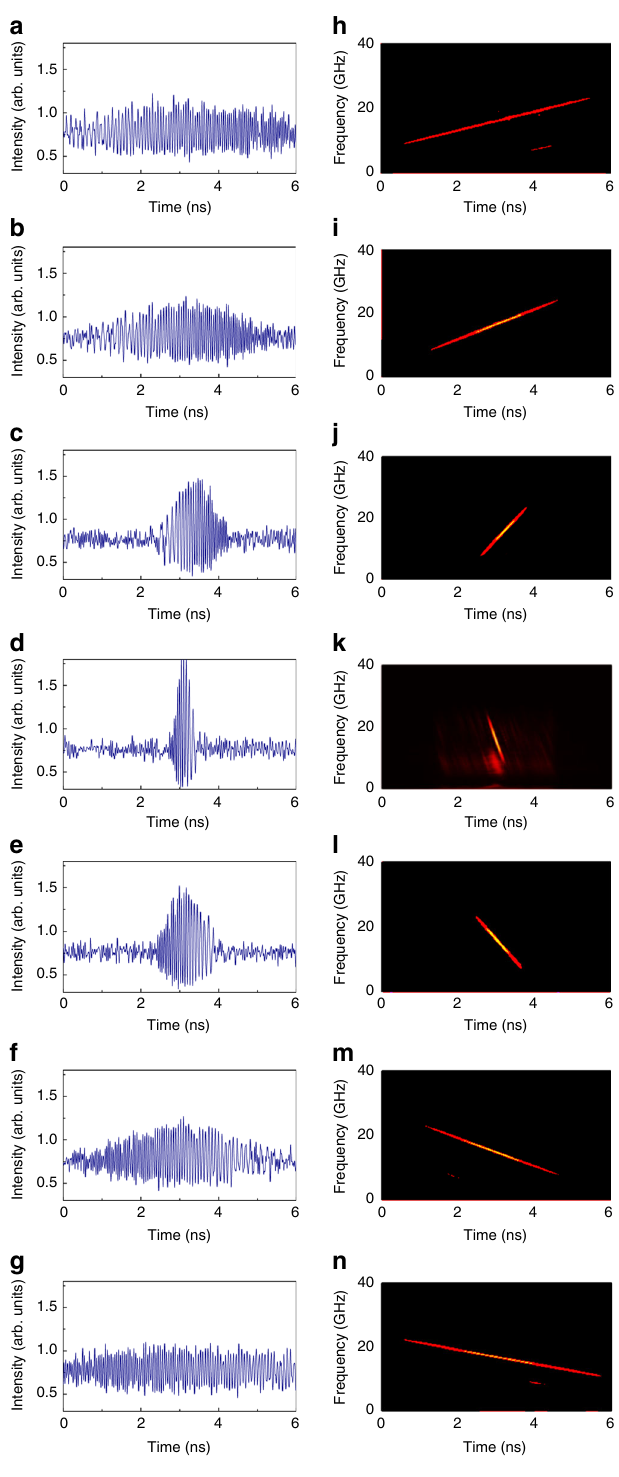
Fig. 7 Arbitrary tuning of the RF chirp rate as a function of f s . The central frequency in all the generated chirp pulses is set to ~15 GHz, and the spectral bandwidth is set to ~12 GHz. The corresponding values of f s (in MHz) for a – f and g are, respectively, equal to − 77.281, − 77.271, − 77.260, − 77.251, − 77.248, − 77.235, and − 77.217. h – n